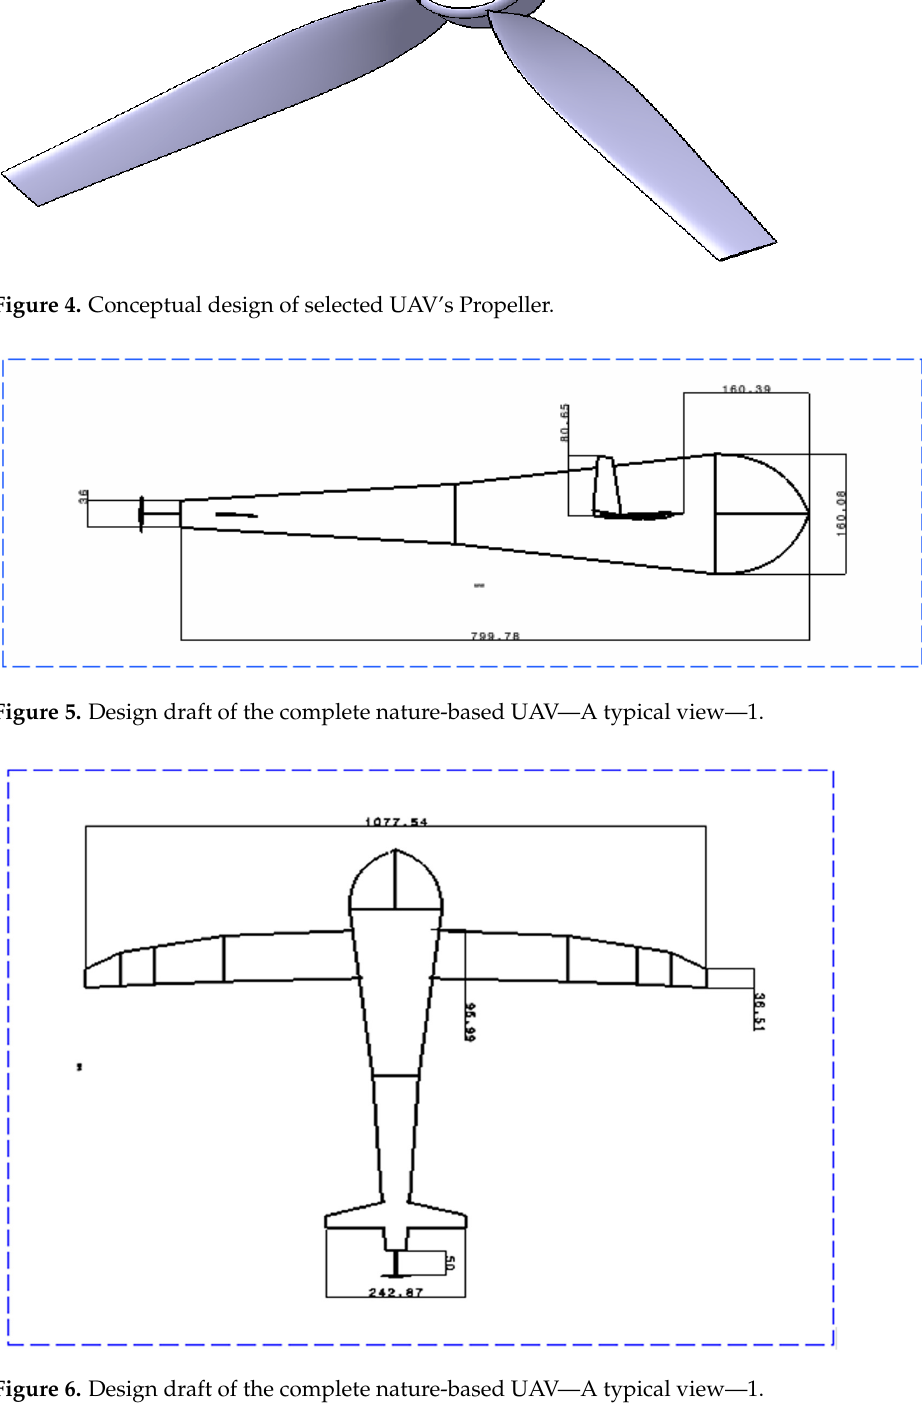
Figure 7. Conceptual design of nature inspired UAV.